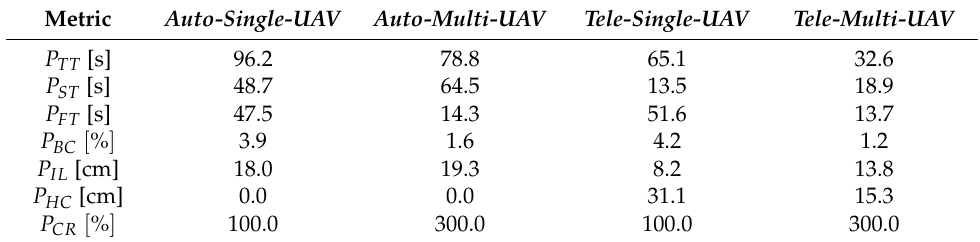
Table 2. Experimental results for each case and performance